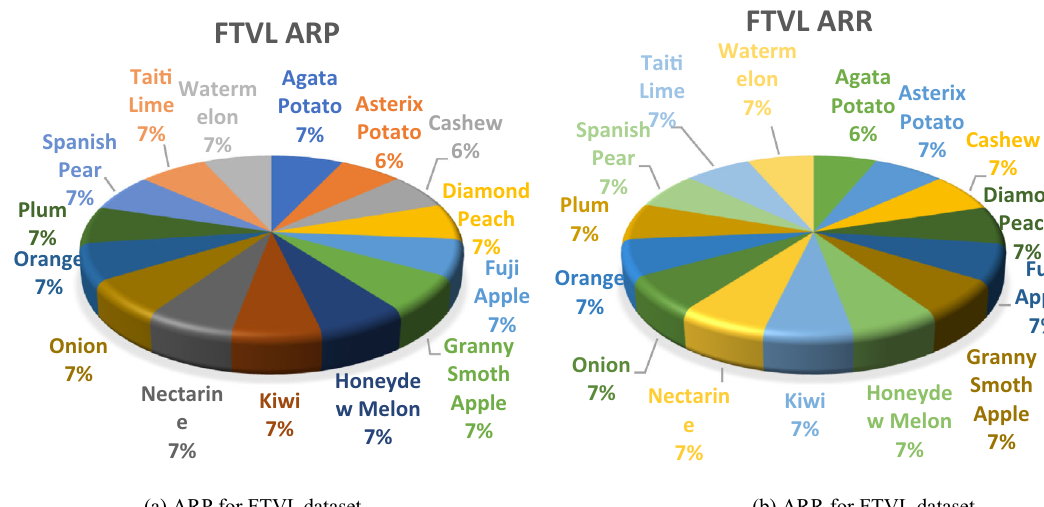
(a) Average Precision FTVL dataset (b) Average Recall FTVL dataset Fig. 12 a Average precision FTVL dataset. b Average recall FTVL dataset